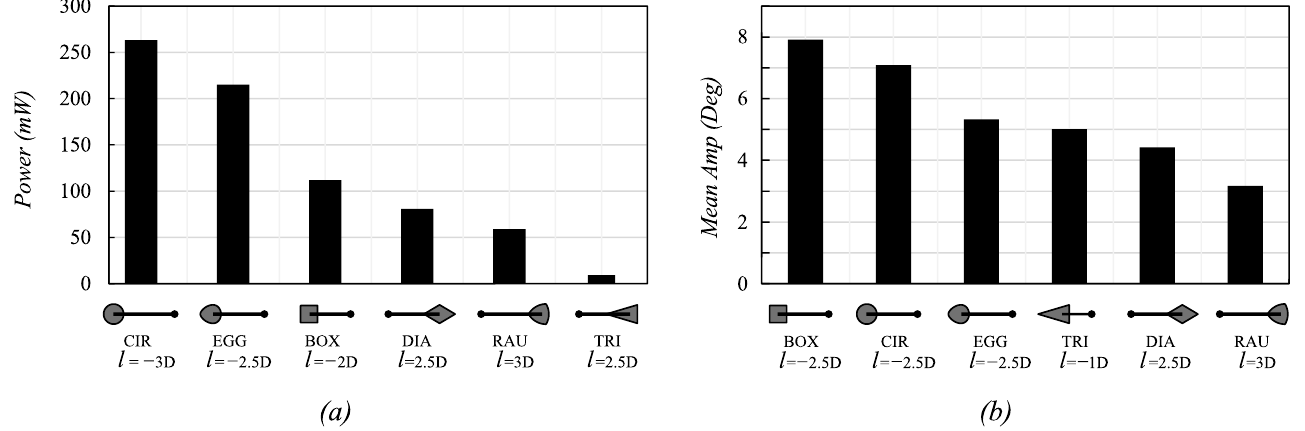
Figure 7. The maximum power output ( a ) and the mean amplitude ( b ) for each cross